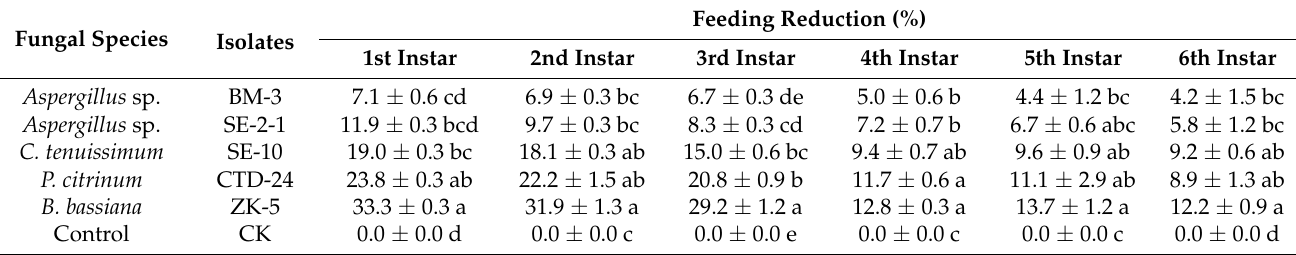
Table 7. Effects of fungal isolates on feeding performance of the sixth instar S. frugiperda larvae at 1 × 10 6 conidia mL − 1 . Feeding Reduction (%) Fungal Species Isolates 1st Instar 2nd Instar 3rd Instar 4th Instar Aspergillus